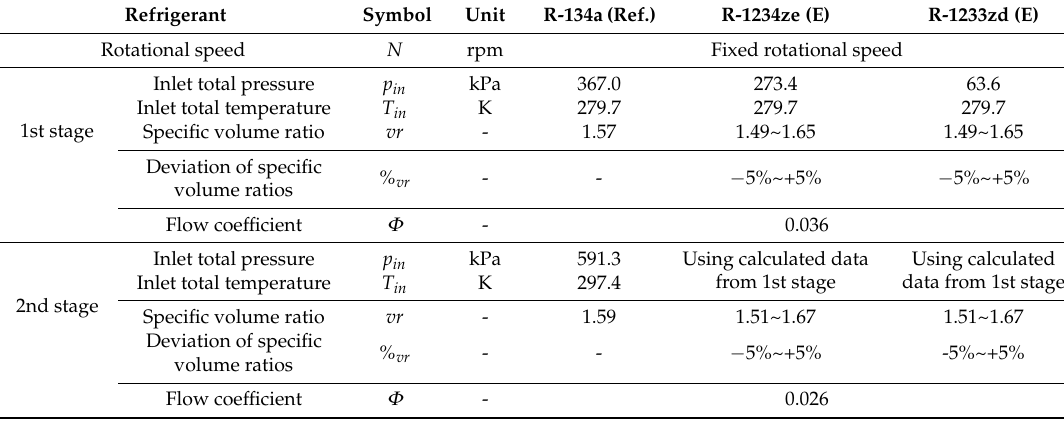
Table 3. Inlet conditions of R-134a compressor and constrain conditions of alternative refrigerants for performance predictions at 100% load